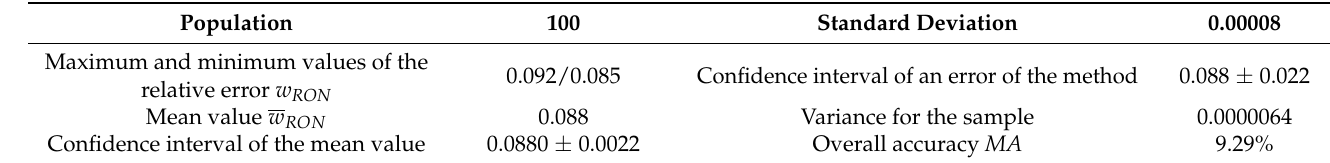
Table 3. Statistical analysis of the measurement